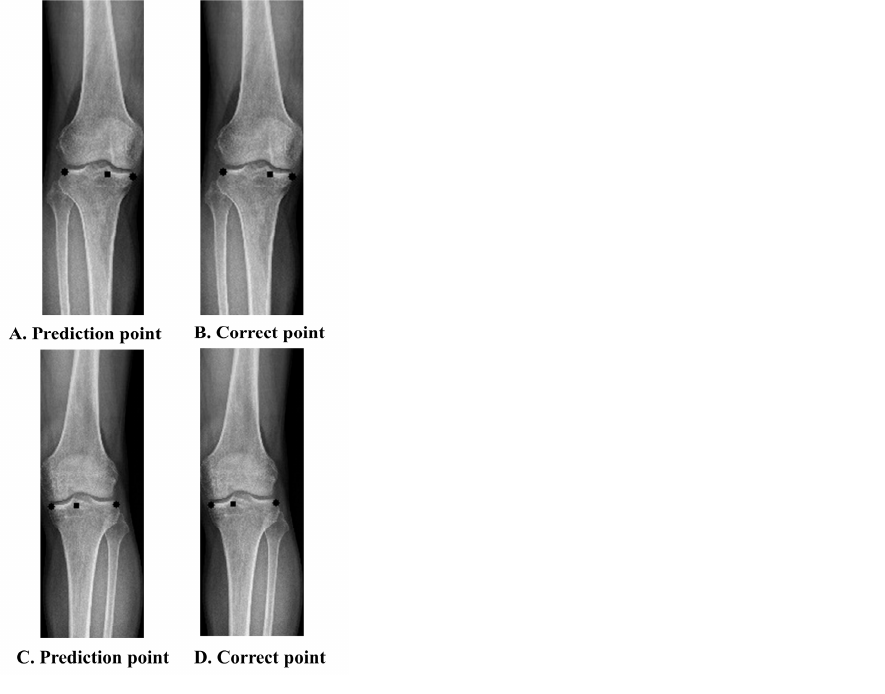
Figure 3. Prediction and correct point. ( A – D ) Prediction point vs. correct point. ( A ) Prediction point in Rt knee, ( B ) correct point in Rt knee, ( C ) prediction point in Lt knee, ( D ) correct point in Lt knee. Prediction point: point predicted by the deep learning algorithm. Correct point: labeled point.